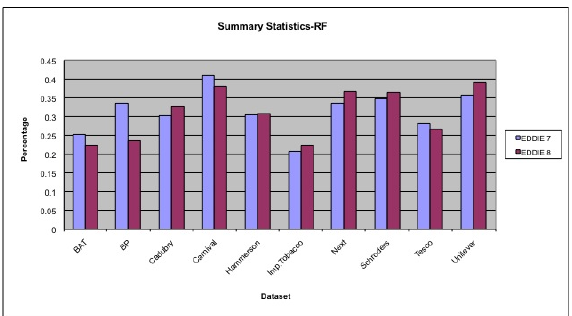
Figure 9 Summary results over 50 runs for RF for EDDIE 7 and EDDIE 8. Results are on the scale of